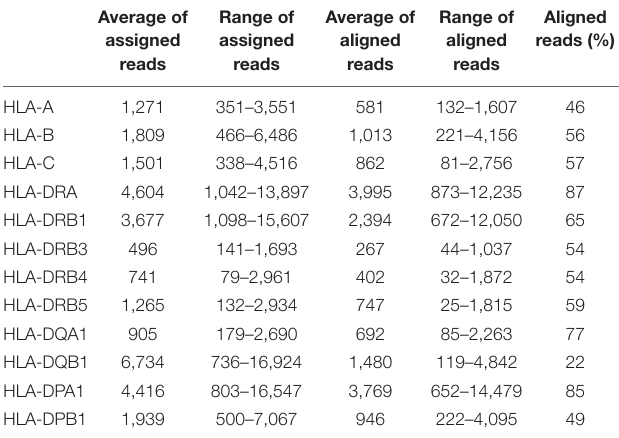
TABLE 2 | Summary of assigned and aligned reads per HLA gene from the SeqPilot software. Average of